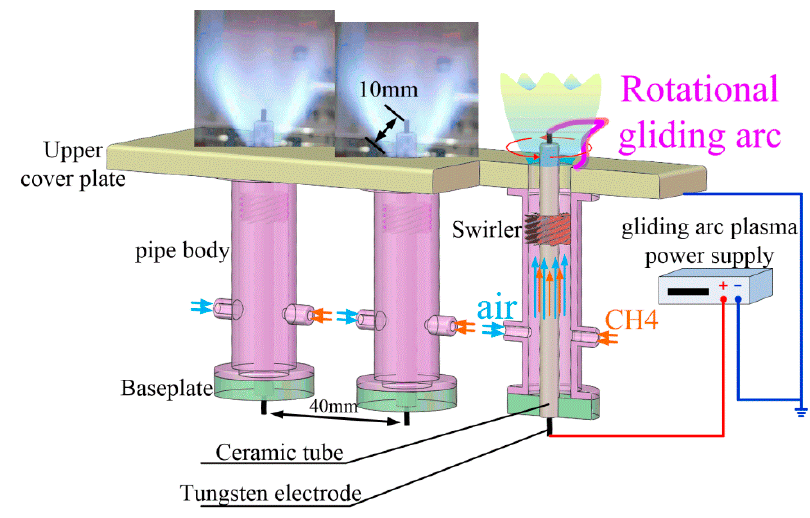
Figure 4. The multi-burner and electrodes.